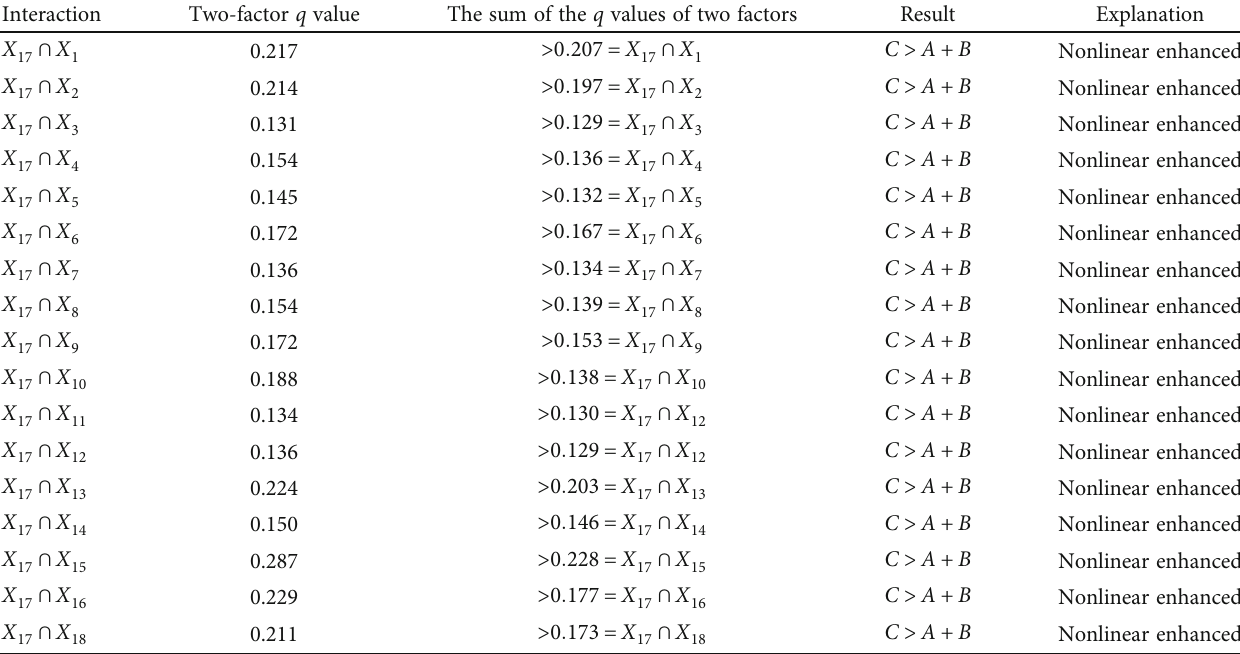
Table 6: The dominant interactions between two covariates in gully density.